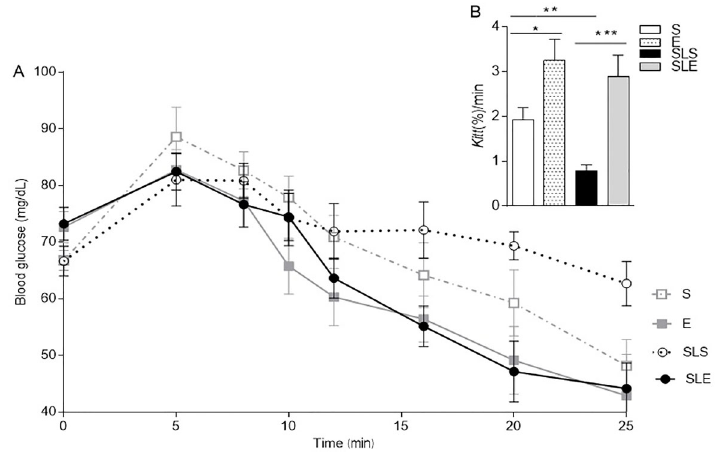
Figure 1. Insulin tolerance test (1.0 U/kg) at 85 days of age ( A ) in the sedentary (S), exercise (E), small-litter sedentary (SLS), and small- litter exercise (SLE) groups. B , Glucose disappearance rate ( Kitt ) of each group. Data are reported as means ± SE (n=8 – 10). *P o 0.05; **P o 0.005; ***P o 0.001